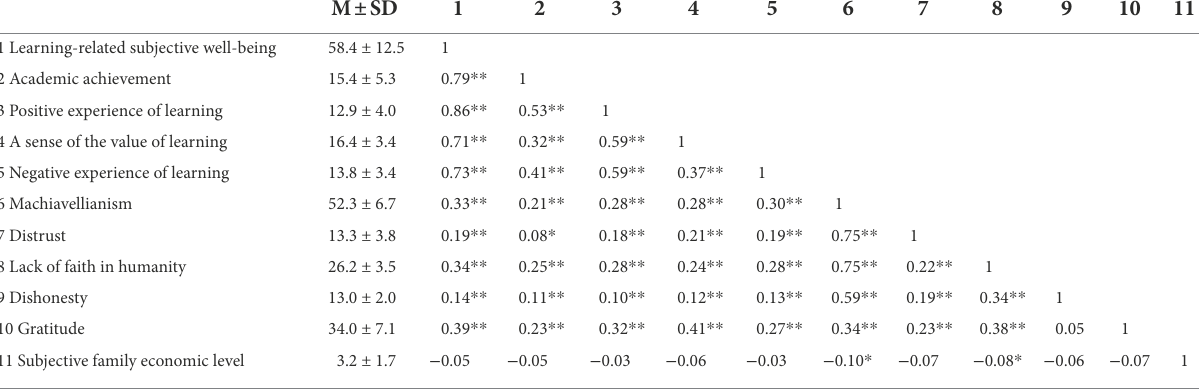
TABLE 1 Descriptive statistics and correlations of the study